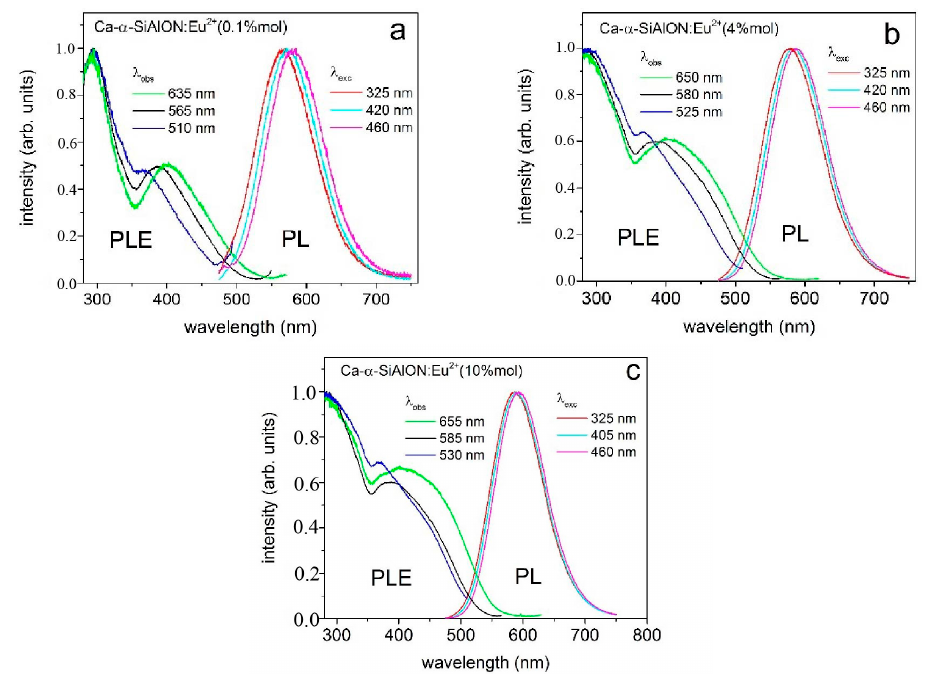
Figure 5. Room temperature photoluminescence (PL) spectra of Ca 0.8 Si 9.6 Al 2.4 O 0.8 N 15.2 :Eu 2+ (x mol%) excited at different excitation wavelength and photoluminescenceexcitation (PLE) spectra of Ca 0.8 Si 9.6 Al 2.4 O 0.8 N 15.2 :Eu 2+ observed at different emission wavelength for ( a ) sample with 0.1 mol % Eu ( b ) sample 4 mol % Eu and ( c ) sample 10 mol % Eu.